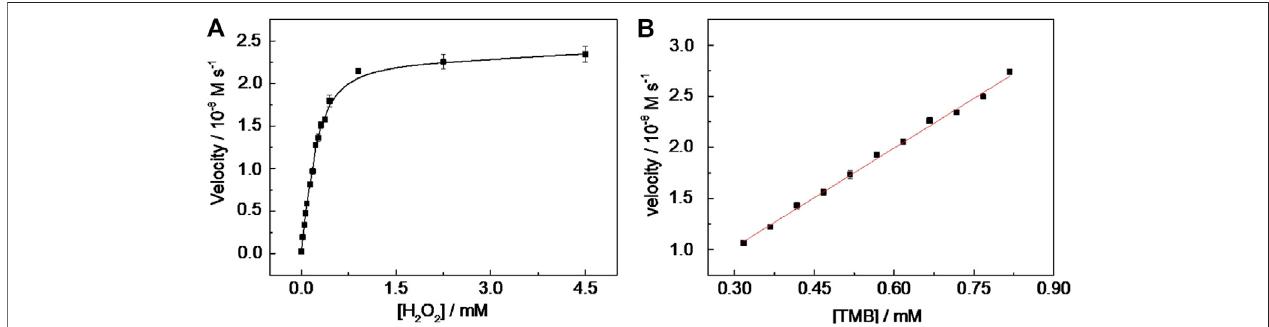
FIGURE 5 | Steady-state kinetic assay of CD-phenylalanine. (A) TMB concentration was fi xed as 0.67 mM and H 2 O 2 concentration was varied and (B) H 2 O 2 concentration was fi xed as 4.5 mM and TMB concentration was varied.